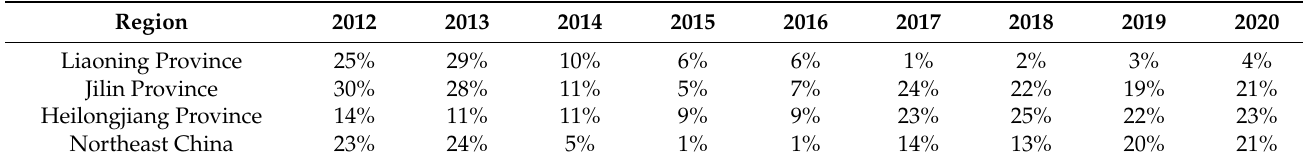
Table 3. Relative error of carbon emission estimation